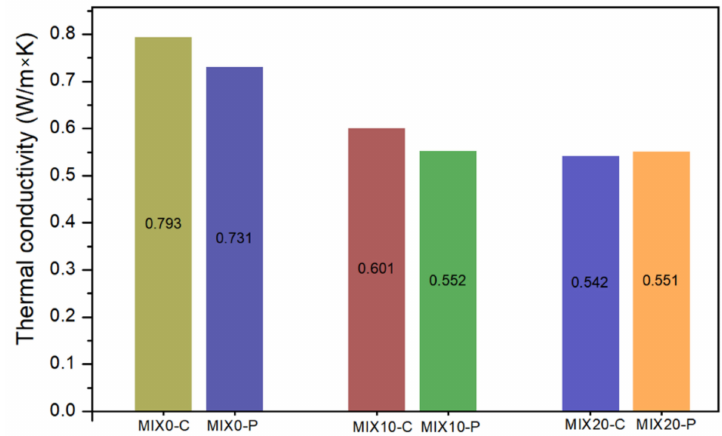
Figure 12. Results of thermal conductivity (experimental temperature 301